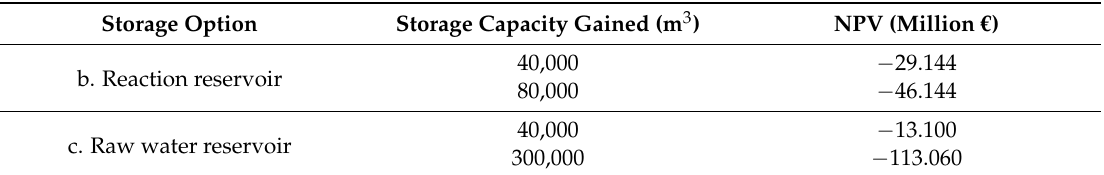
Table 2. Net present values (NPVs) for minimum and maximum possible capacity of storage options (b) and